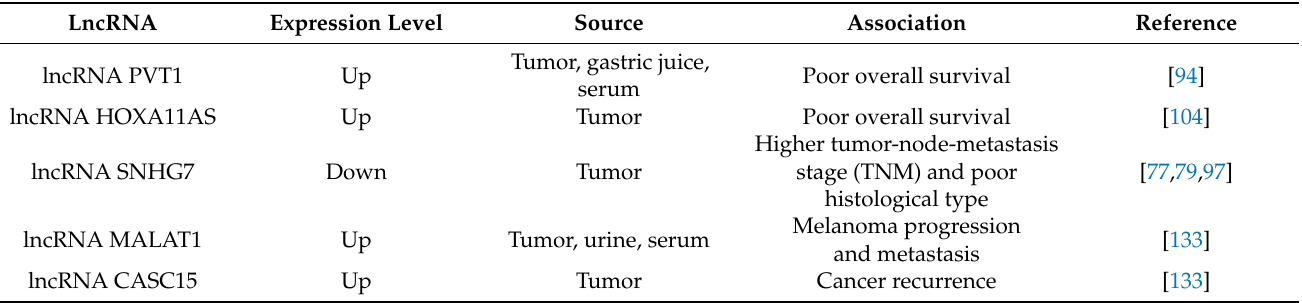
Table 3. UM lncRNA diagnosis